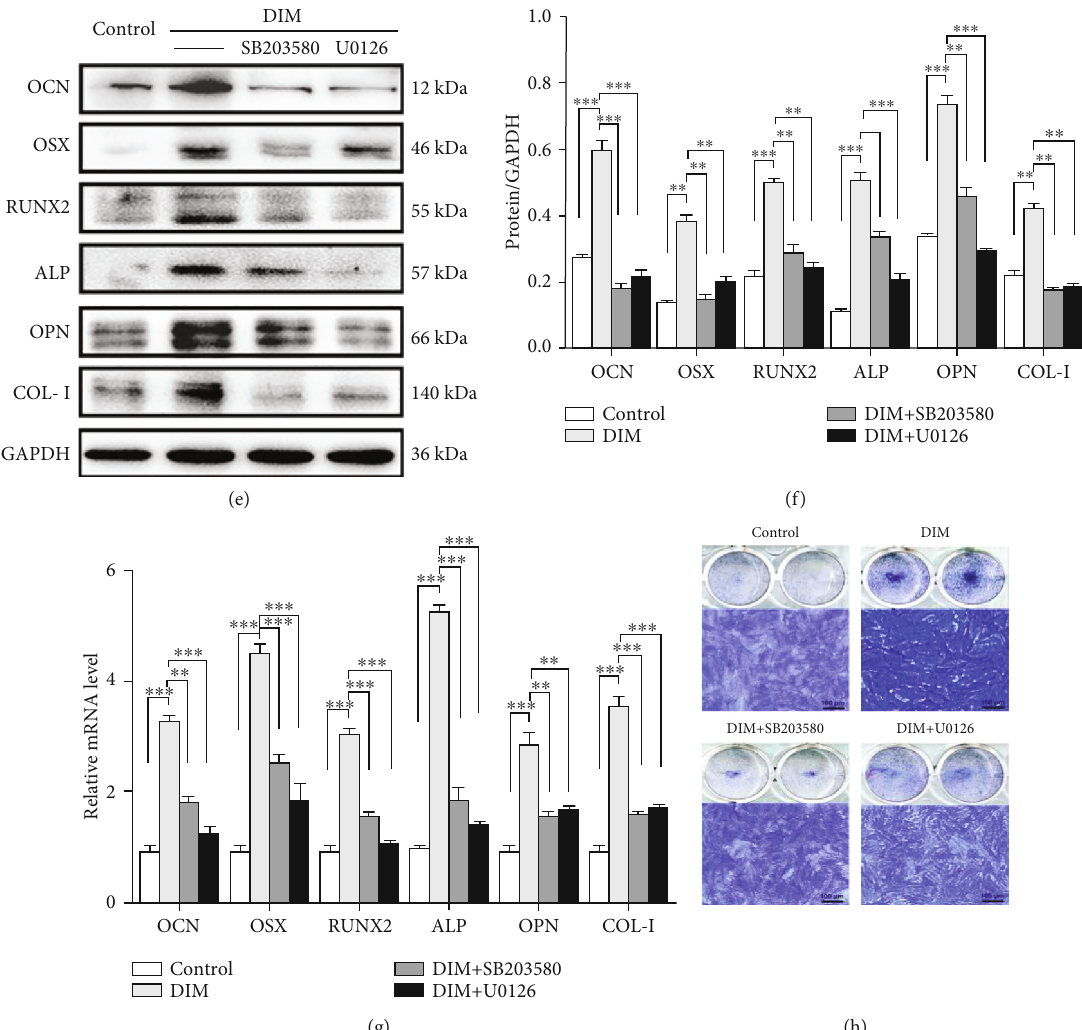
Figure 5: E ff ects of DIM on the ERK and P38 MAPK pathways involved in BMMSC osteogenic di ff erentiation. (a) Protein expression levels of ERK, p-ERK, JNK, p-JNK, p38, and p-p38 were determined by western blot. (b) Quanti fi cation of (a). ∗∗∗ P < 0 : 001 . (c) After BMMSCs were cultured with pathway inhibitors, protein expression levels of ERK, p-ERK, JNK, p-JNK, p38, and p-p38 were determined by western blot. (d) Quanti fi cation of (c). ∗∗∗ P < 0 : 001 . (e) Protein expression levels of OCN, OSX, RUNX2, ALP, OPN, and COL-I were